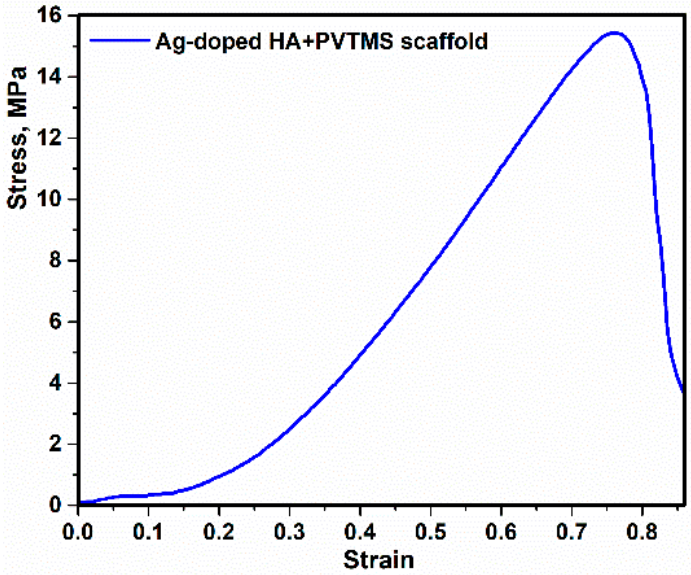
Figure 12. The curve of stress–strain compression of Ag-doped HA+PVTMS scaffold.